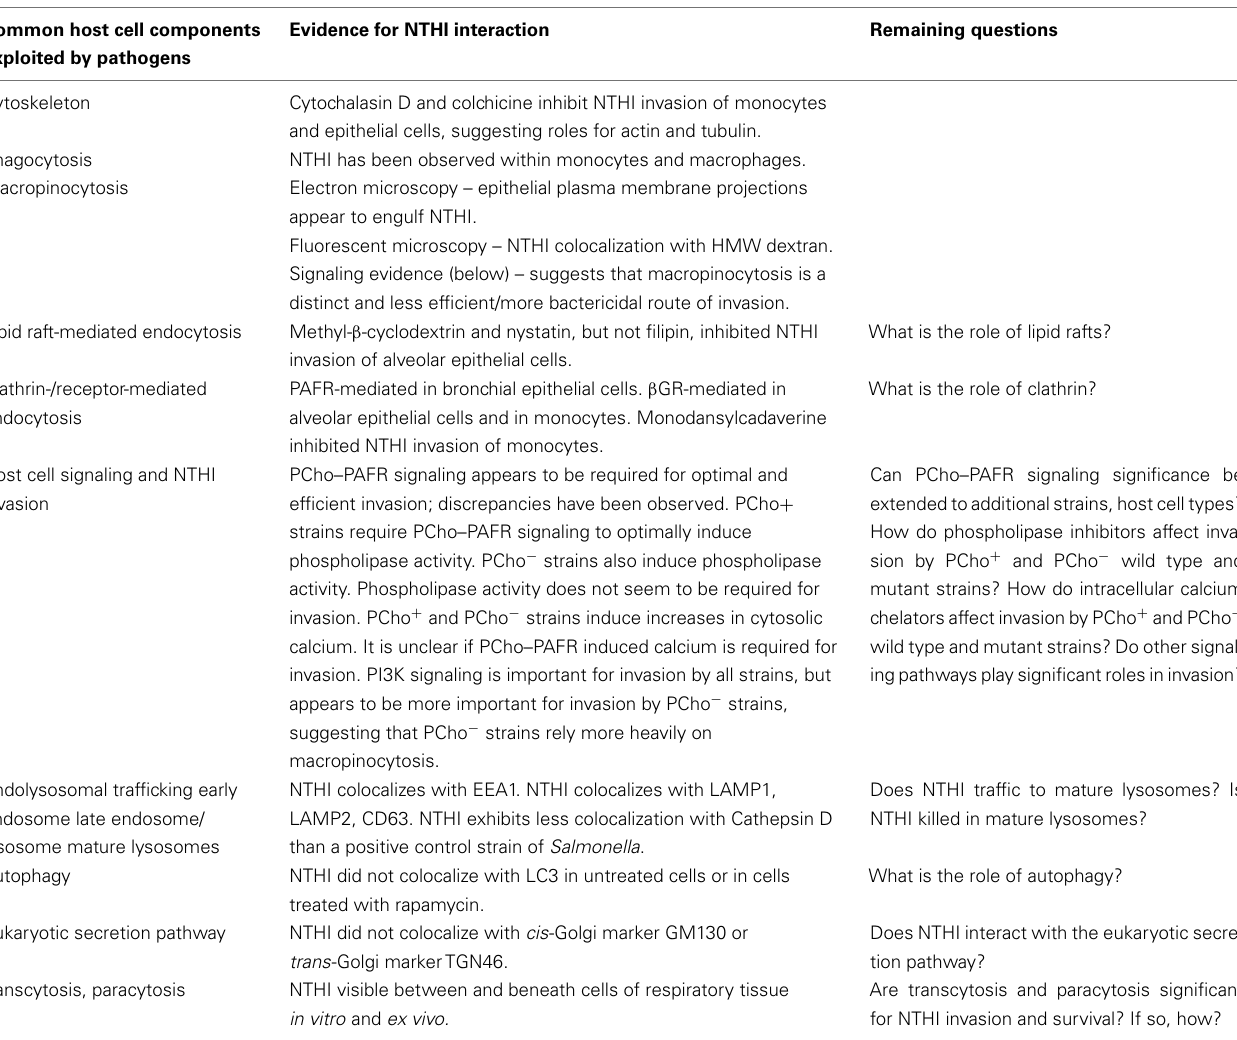
Table 1 | Current knowledge of NTHI invasion and